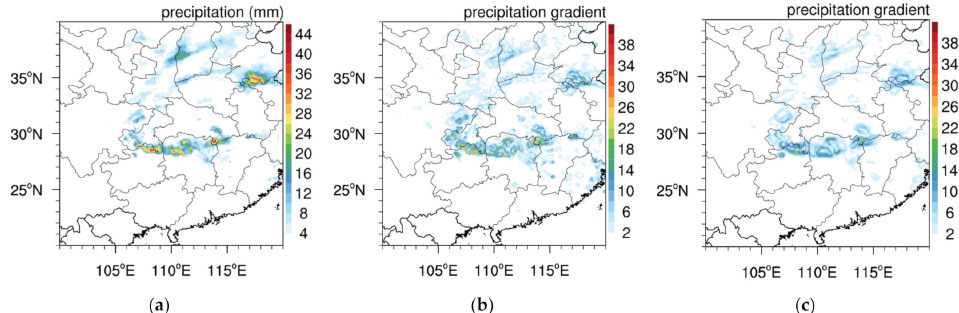
Figure 5. ( a ) The original precipitation distribution, and mm stands for millimeters, which is the unit of precipitation. The following are the same; ( b ) the gradient map (mm) of original precipitation; and ( c ) the gradient map of precipitation using the interpolation